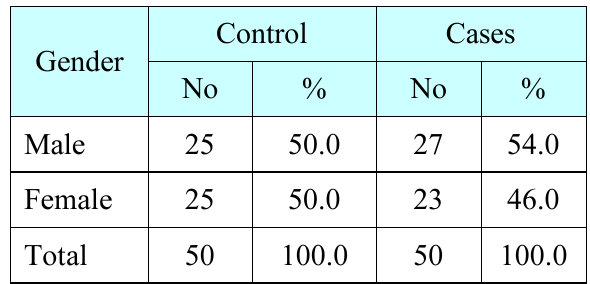
Table 2: Gender distribution of subject studied